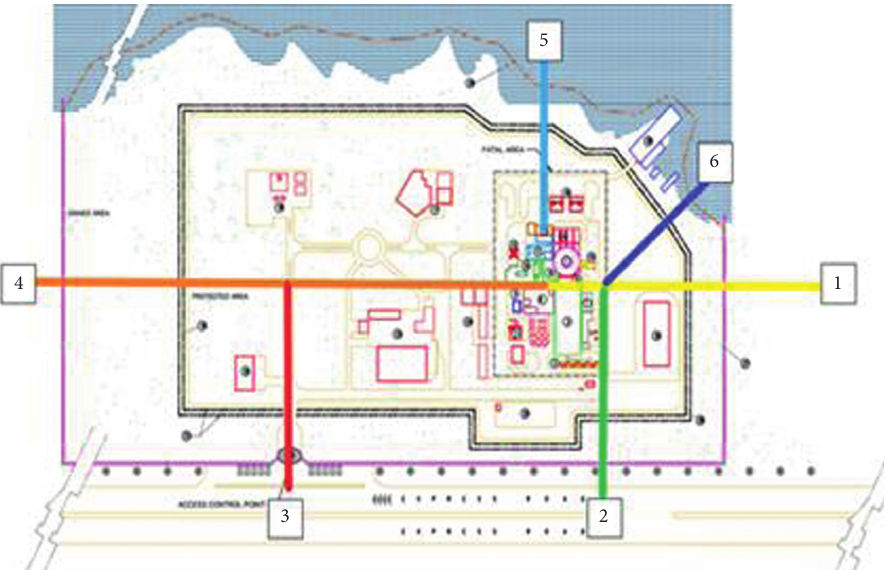
Figure 5: Adversary attack